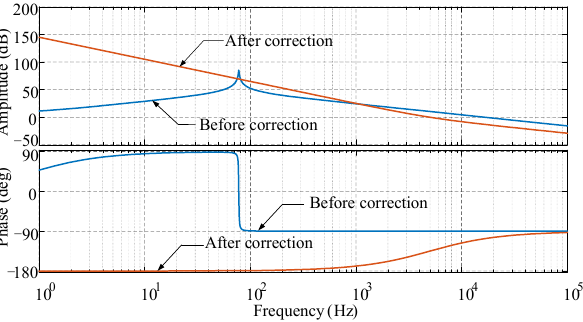
Figure 11. Open-loop Bode diagram of the current loop before and after correction.